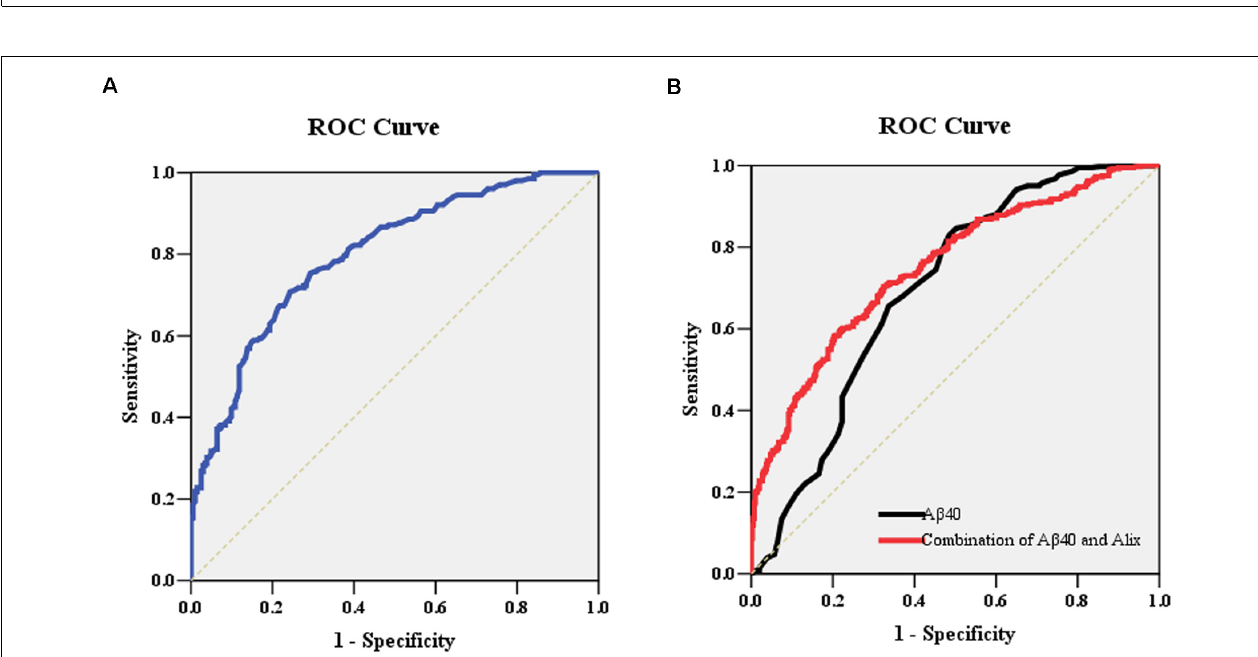
FIGURE 3 | (A) Correlation analysis between Alix serum levels and MMSE scores in AD patients. (B) Correlation analysis between Alix and A β 40 in serum levels. Correlation was assessed using the Spearman correlation coefficient. A significant positive correlation between serum Alix level and MMSE score ( r = 0.80, p < 0.001) was observed, as well as a significant negative correlation between Alix and A β 40 in serum levels ( r = − 0.60, p < 0.001). Correlation lines are also shown.